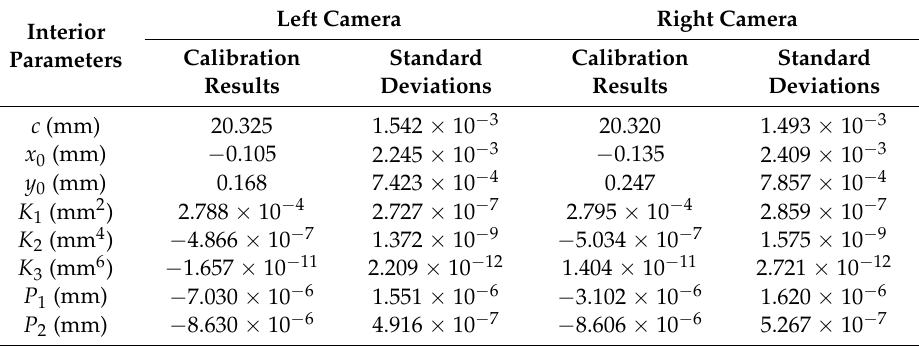
Table 1. Self-calibrating bundle adjustment results of the camera parameters.